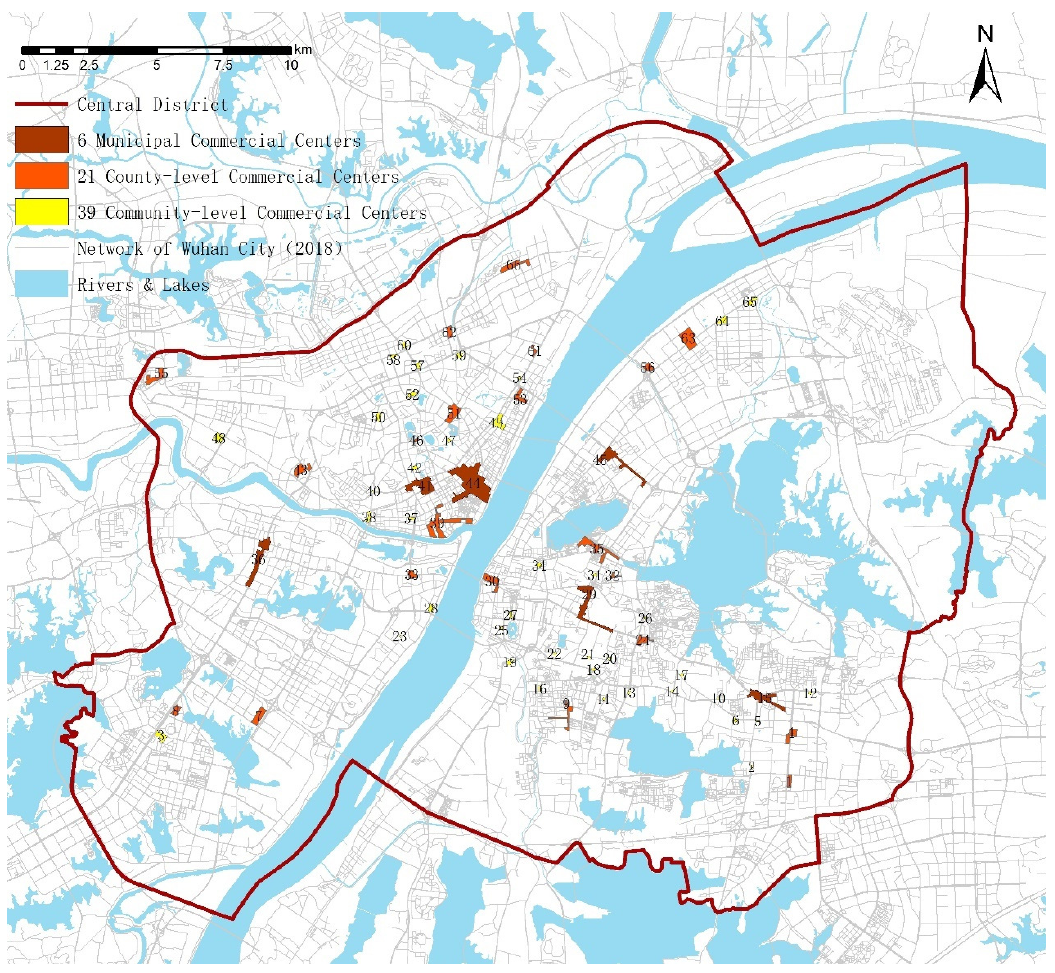
Figure 2. Spatial distribution of 66 commercial centers.